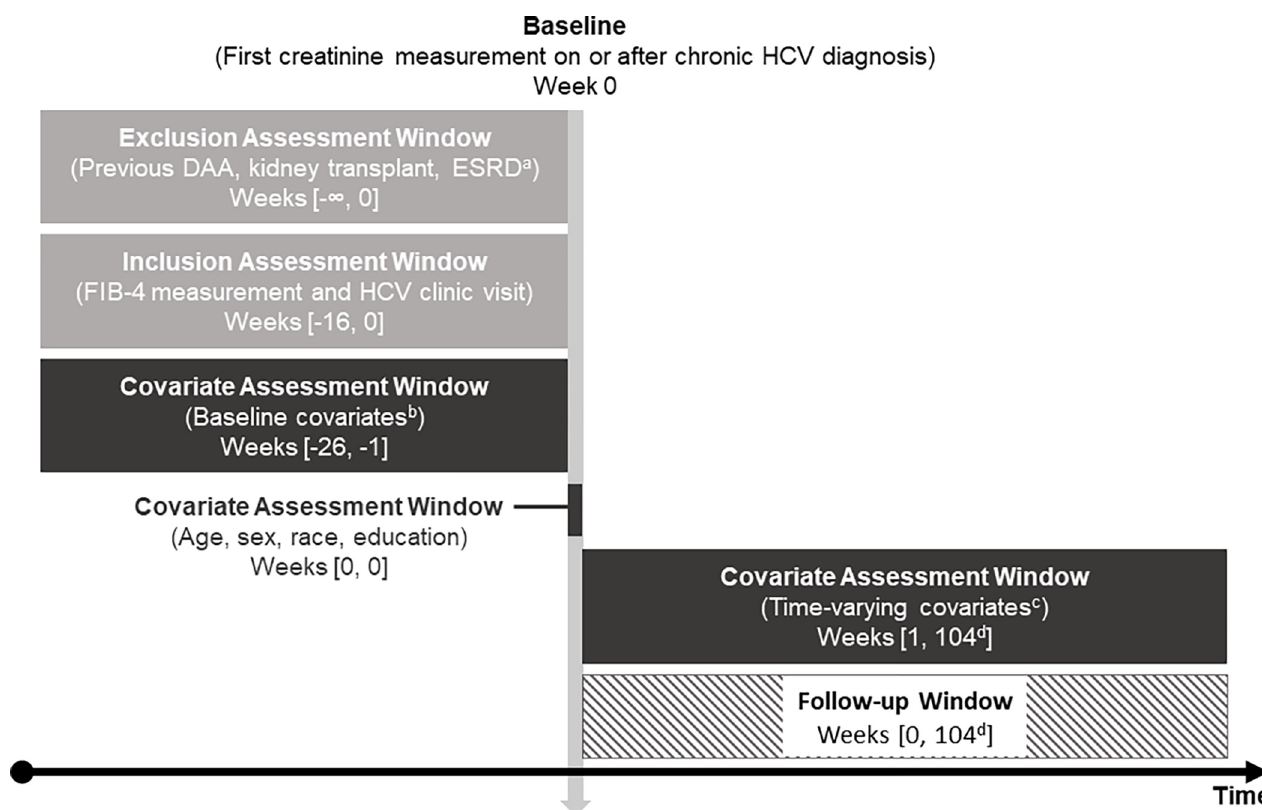
Fig 2. Description of cohort entry timeline. a End stage renal disease (ESRD) includes dialysis and Stage 5 chronic kidney disease (CKD). b Baseline covariates: Fibroscan, genotype, body mass index, insurance type, alanine transaminase, aspartate transaminase, platelets, HIV, drug or alcohol use disorder, mental illness, diabetes, hypertension. c Time-varying covariates: alanine transaminase, aspartate transaminase, platelets, change in eGFR, diagnosis of drug or alcohol use disorder, mental illness, hypertension, clinic visits, treatment with DAAs. d Follow-up window ends at the earliest of one of the following events: death, kidney transplant, ESRD, 104 weeks (2 years) post-baseline, administrative end of follow-up (December 2018), or, in Trial 1, date of outcome.